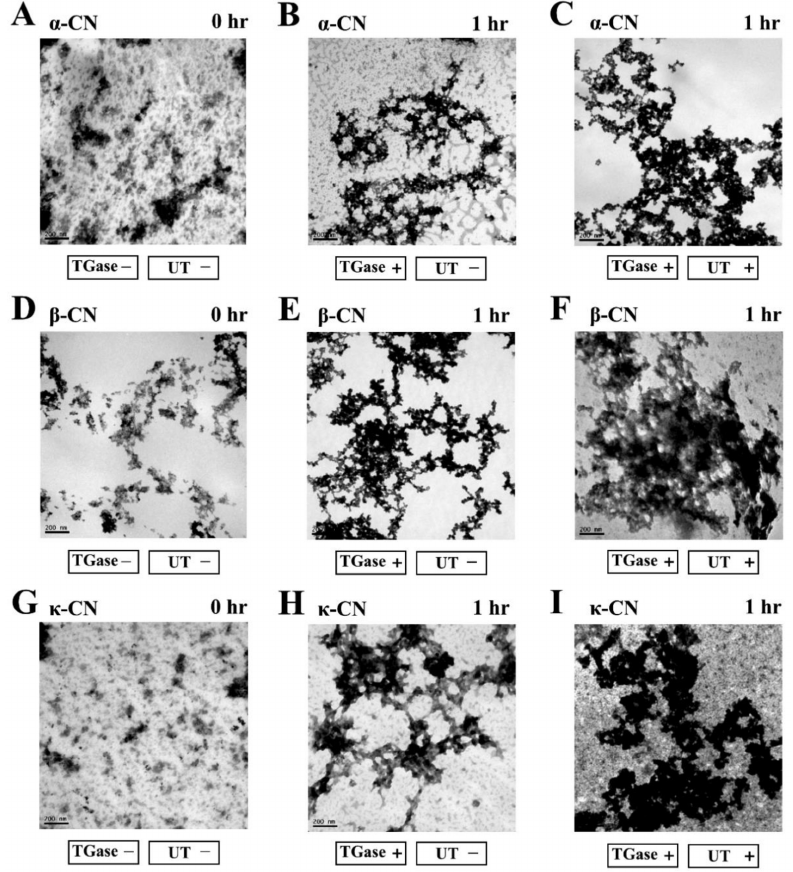
Figure 6. Transmission electron microscopy of the individual α s -CN, β -CN and κ -CN treated with/without TGase (6.0 units/mL) and UT at 30 ◦ C for 0 and 60 min. ( A ) α s -CN, ( B ) α s -CN with TGase for 60 min, ( C ) α s -CN with TGase and UT for 60 min, ( D ) β -CN, ( E ) β -CN with TGase